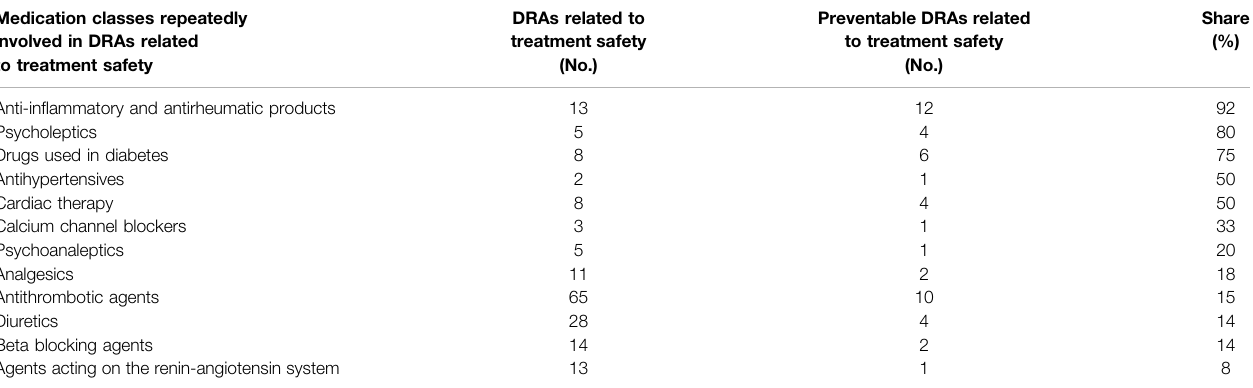
TABLE 13 | Medication classes and corresponding share of preventability of DRAs related to treatment safety. Medication classes repeatedly involved in DRAs related to treatment safety